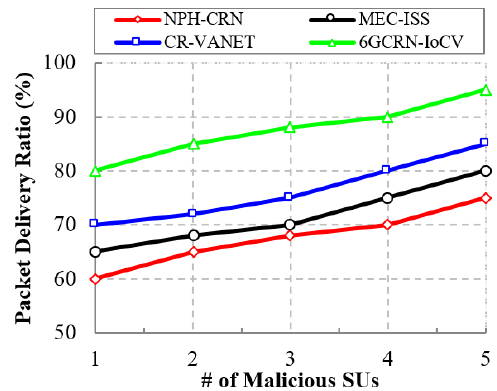
Figure 10. Packet Delivery Ratio vs. the number of malicious SUs.